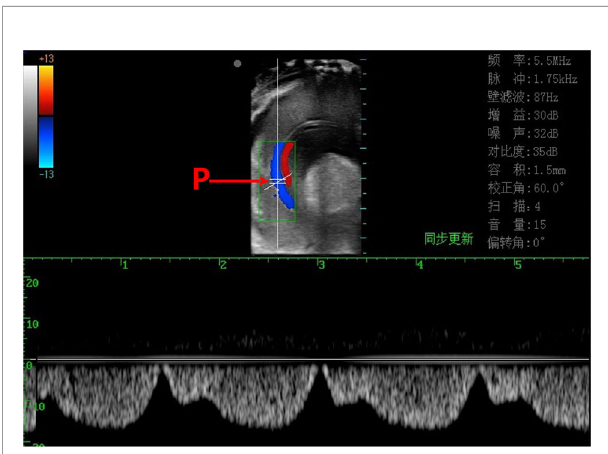
FIGURE 1 | Doppler ultrasonic imaging (pulse mode) of the scallop ’ s inner tissue and the branchial vessel blood fl ow dynamics. Red line shows the blood fl ow (upward) in afferent branchial vessel and blue line the blood fl ow (downward) in efferent branchial vessel. The short parallel lines (P) indicate the sampling site, at which the real-time blood fl ow dynamic is recorded at the lower part of the fi